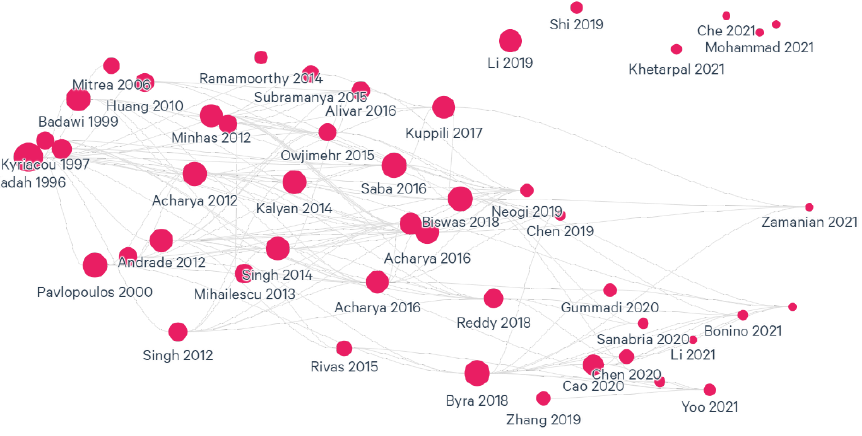
Figure 4. Selected studies’ relevance and recommended papers.